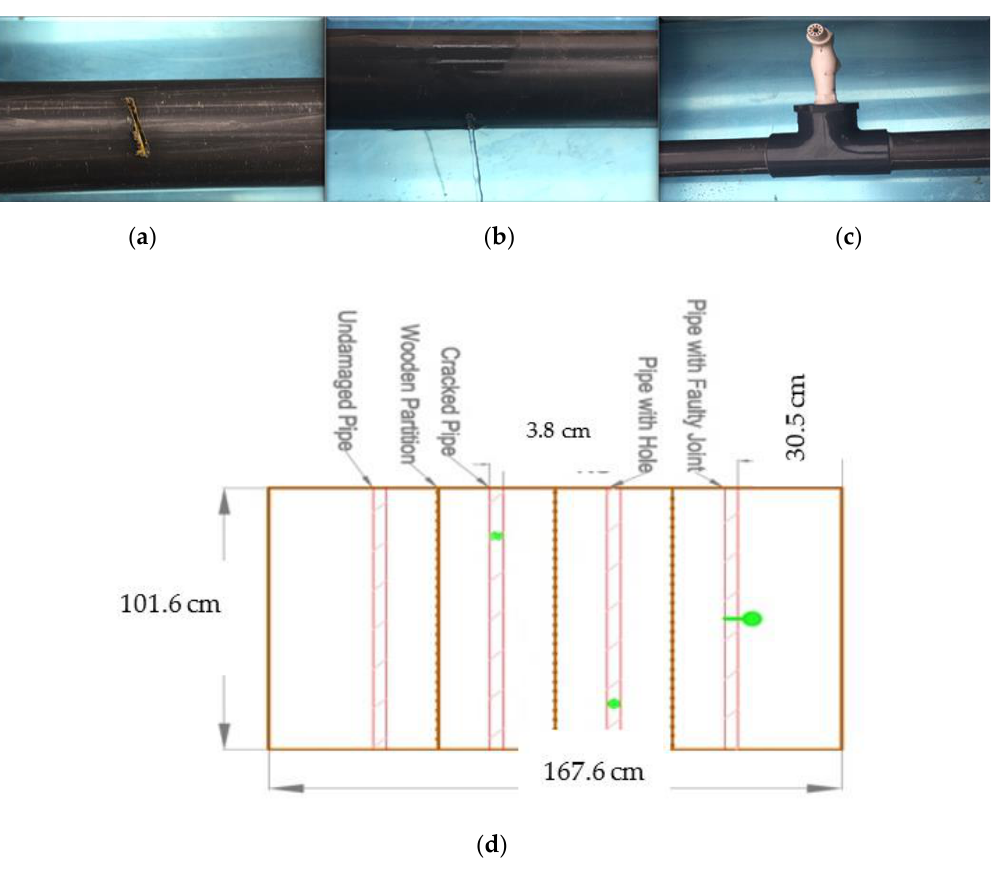
Figure 4. Leaks and their locations: ( a ) crack; ( b ) hole; ( c ) faulty joint; and ( d ) top view with leak position marked green.